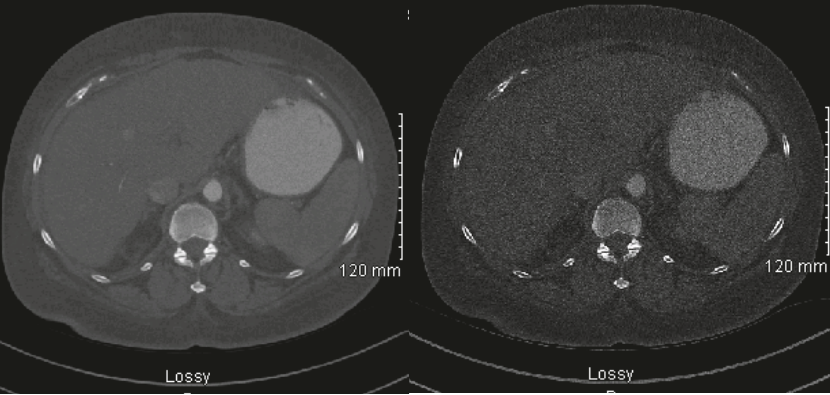
Figure 1: Abdominal Computed Tomography (CT), 2015.